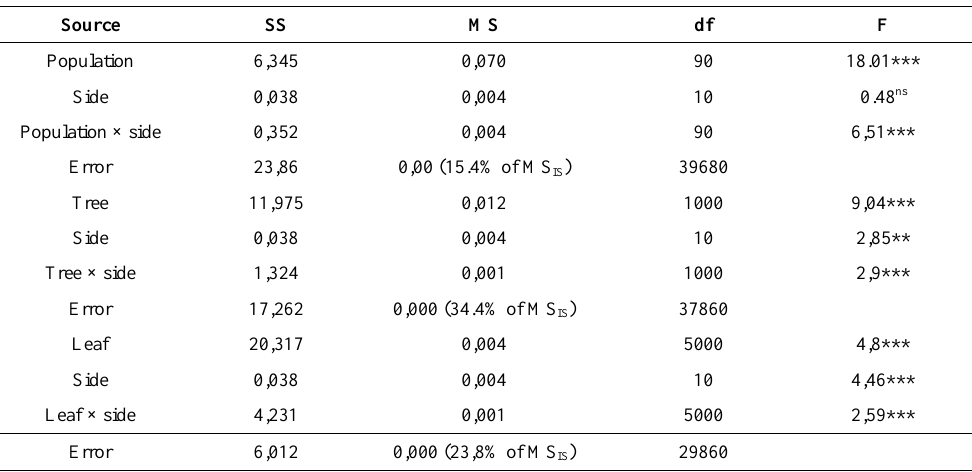
Table 2. Procrustes ANOVA